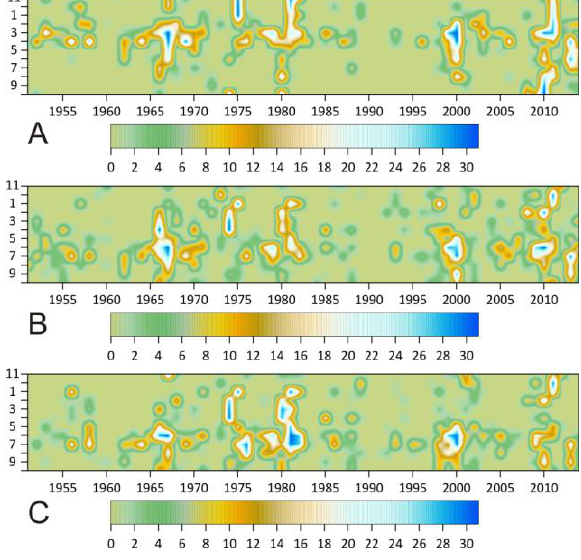
Fig. 4. The annual and long-term courses of number of days with flood in Krasnystaw (A), Krzak (B) and Zwierzyniec (C). In terms of volume, the floods in Krasnystaw are the largest, mainly due to the size of the supply area. The volume of freshets does not go hand in hand with their duration. The highest flood volumes in Krasnystaw were registered in 1964, 1967 and 2000 (144, 125 and 114 million m 3 ), in Krzak in 1967 (nearly 41 million m 3 ), while in Zwierzyniec in 1975 and 1981 (22 and